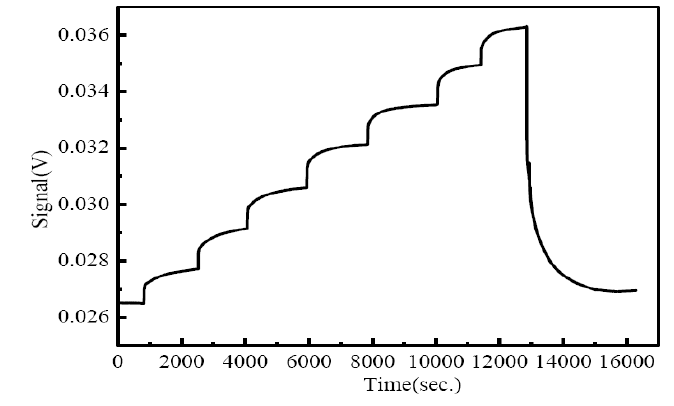
Figure 10. Plot of temporal response of the fiber sensor with respect to injection of an increasing sequence of concentrations or refractive indices of